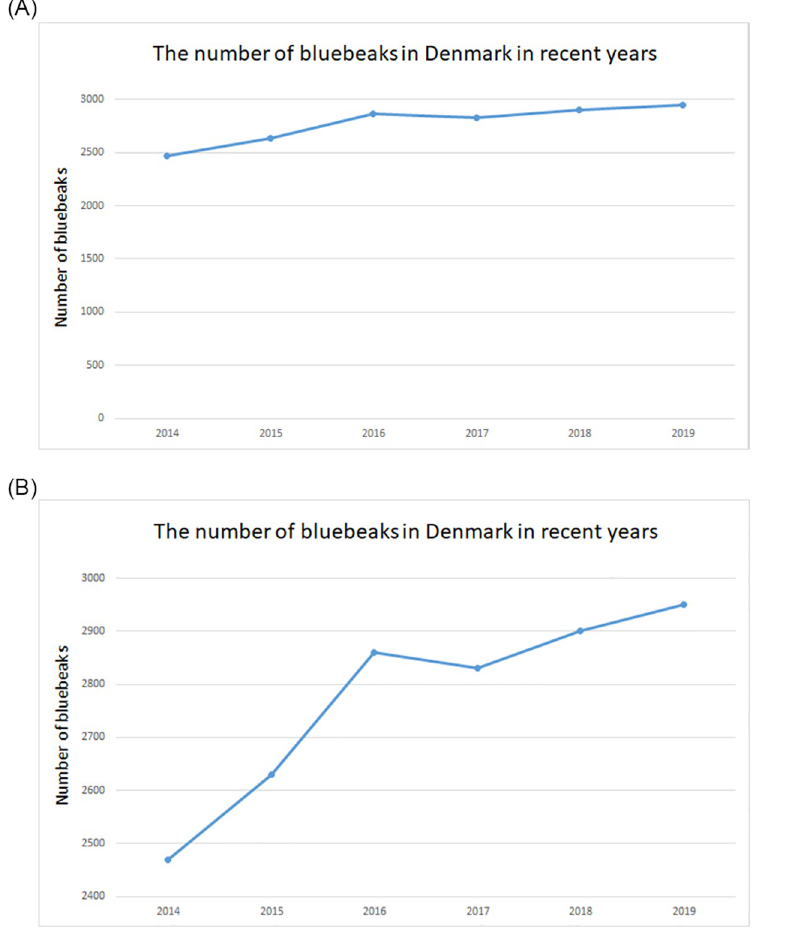
Fig 1. The two alternative